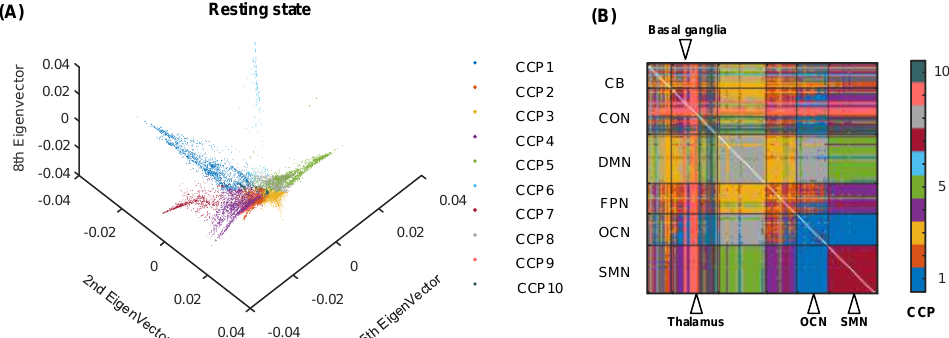
Figure 2. The resting-state CCPs distilled by our method framework. ( A ) Each CCP marked in the same color is distributed in one specific direction. ( B ) The CCPs are rearranged into the ROI-ROI index